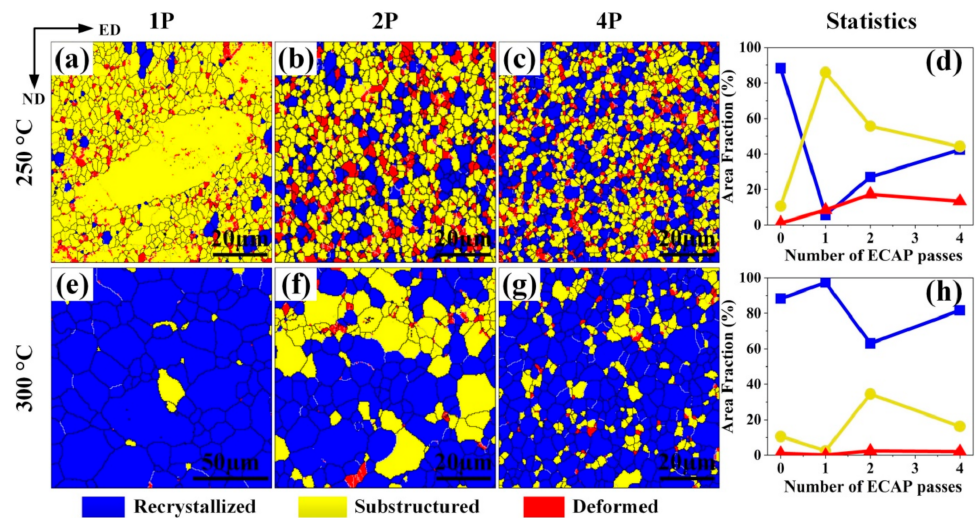
Figure 7. Recrystallization maps of 250 ◦ C ECAP samples ( a – d ) and 300 ◦ C ECAP samples ( e – h ). ( a , e ) One pass, ( b , f ) two passes, ( c , g ) four passes, and ( d , h ) the flow curves of recrystallization tendency.